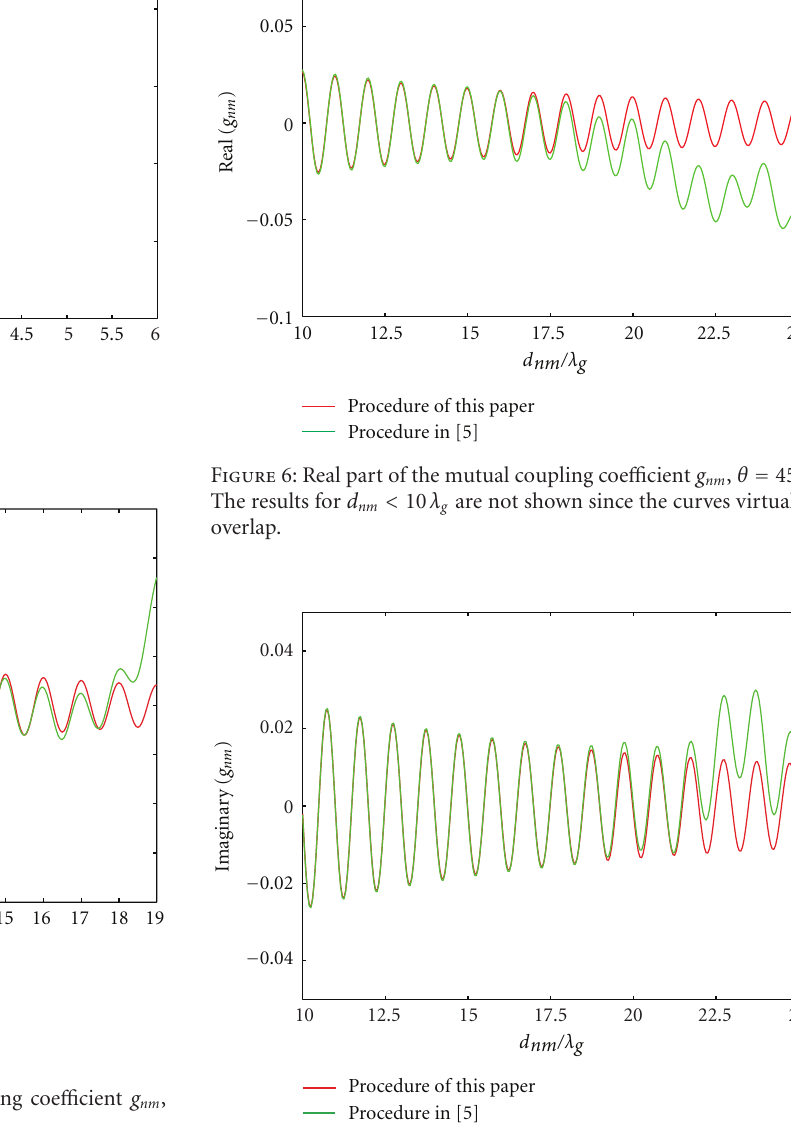
Figure 7: Imaginary part of the mutual coupling coe ffi cient g nm , θ = 45 ◦ . The results for d nm < 10 λ g are not shown since the curves virtually